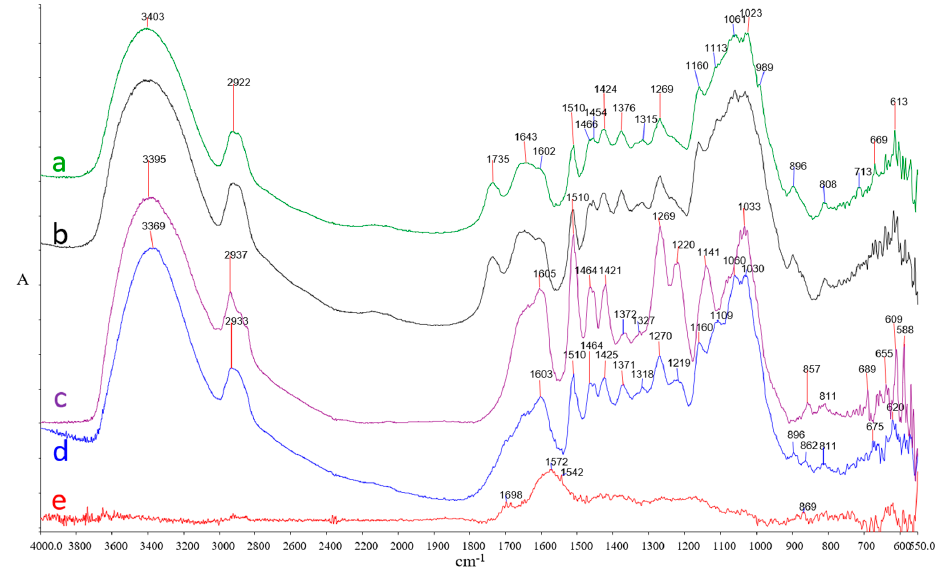
Figure 4. Spectra obtained for reference samples, ( a ) Pinus halepensis and ( b ) Pinus brutia ( c ) uncharred ( d ) semi-charred, and ( e ) charred archaeological samples.